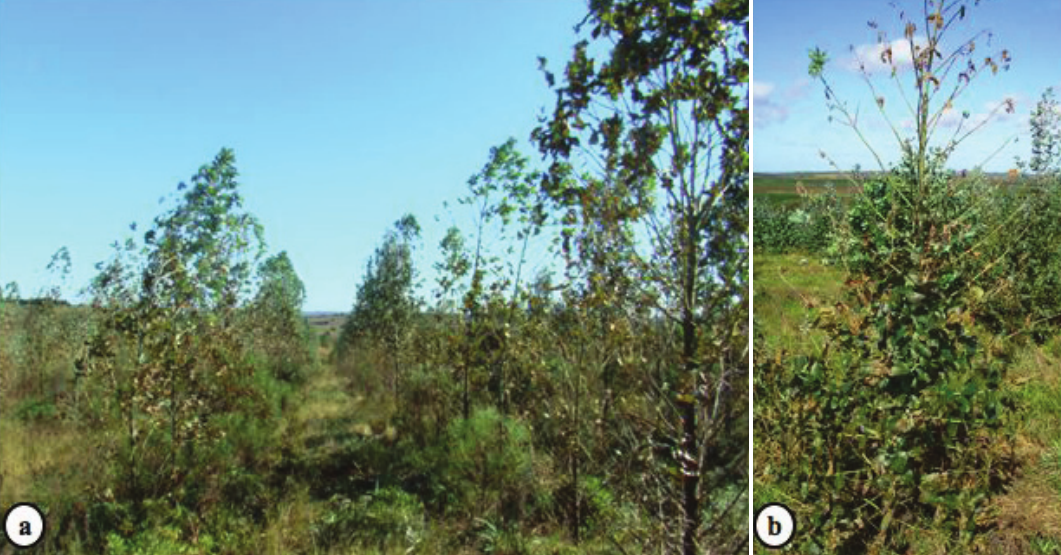
Fig. 1. Teratosphaeria nubilosa lesions on juvenile and adult Eucalyptus globulus foliage. a. Single and coalescing lesions on the current season’s growth and b. prematurely shed juvenile leaves. c. Lesions on young adult leaves and d. mature adult leaves. Note the light-brown pigmentation towards the borders of the lesions.